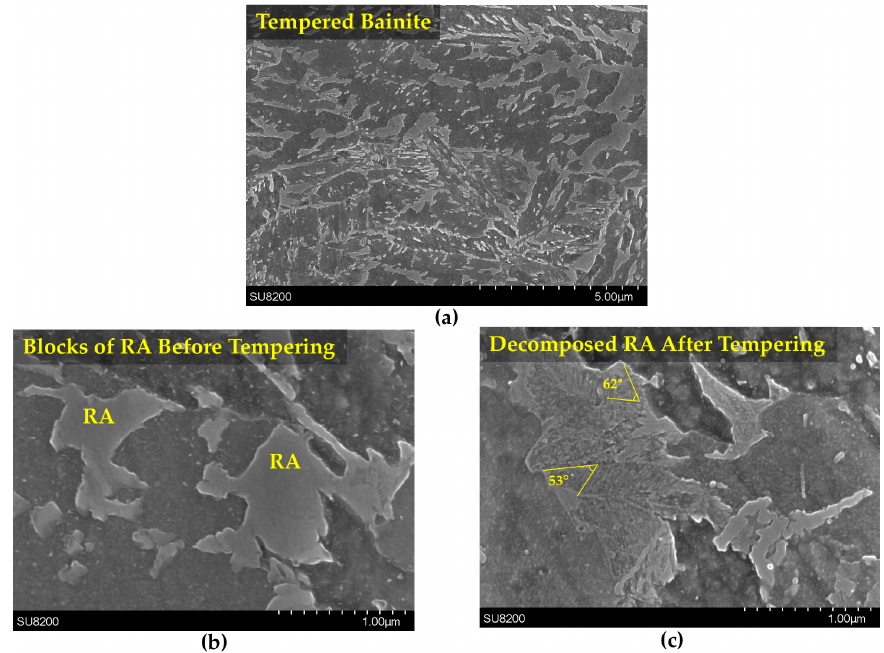
Figure 10. SEM images of microstructure evolution in the bainitic sample during non-isothermal tempering at heating rate of 5 °C/min: ( a ) The microstructure after tempering; ( b ) blocks of retained austenite (RA) prior to tempering and ( c ) blocks of decomposed retained austenite after tempering.